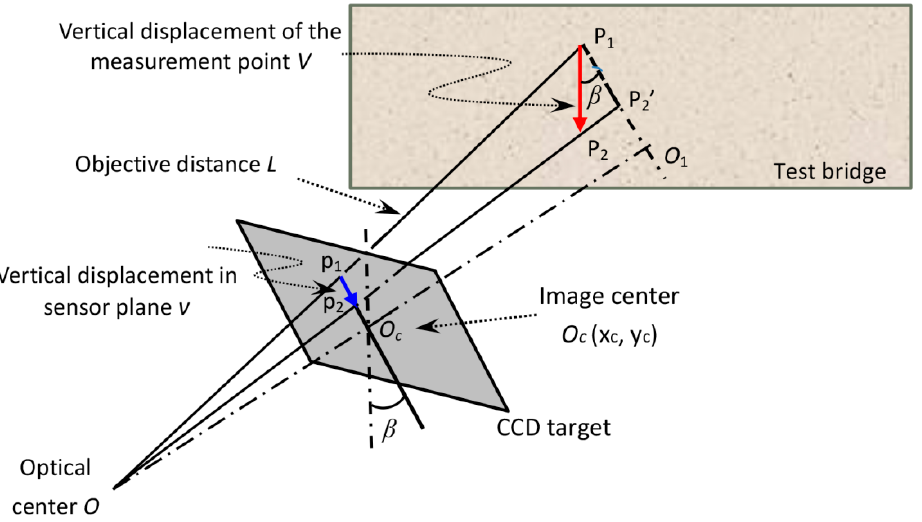
Figure 2. Schematic representation of the calibration model.